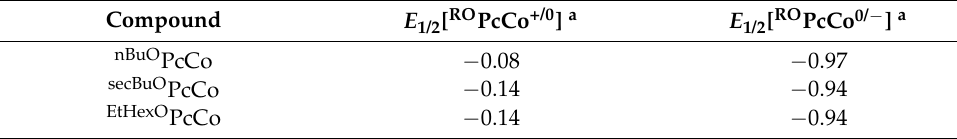
Table 1. Homogeneous RO PcCo reduction potentials in benzonitrile.